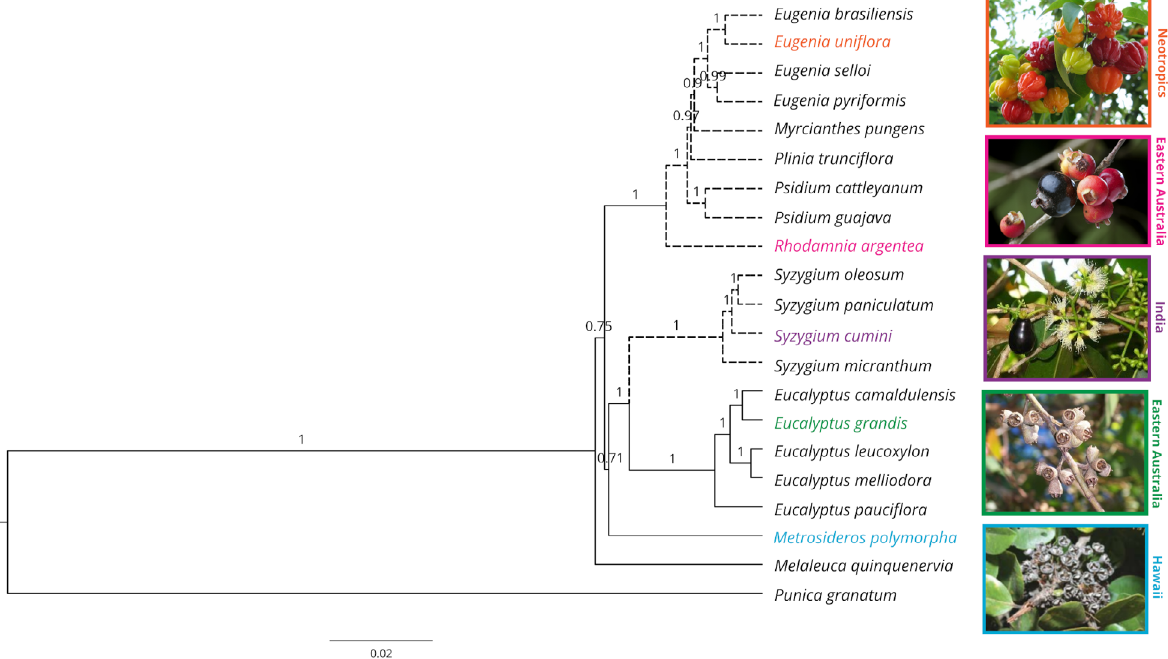
Figure 2 – Maximum clade-credibility phylogeny of Myrtaceae using concatenated sequences of five single-copy nuclear markers MCM5, MLH1, MSH1, SMC1 and SMC2 . Posterior probabilities for each node are indicated and branch lengths are scaled according to the number of substitutions per site. Dashed lines correspond to species with fleshy fruits in the Myrtaceae family. Species with colored scientific names are those represented in pictures on the right, along with an indication of species occurrence.